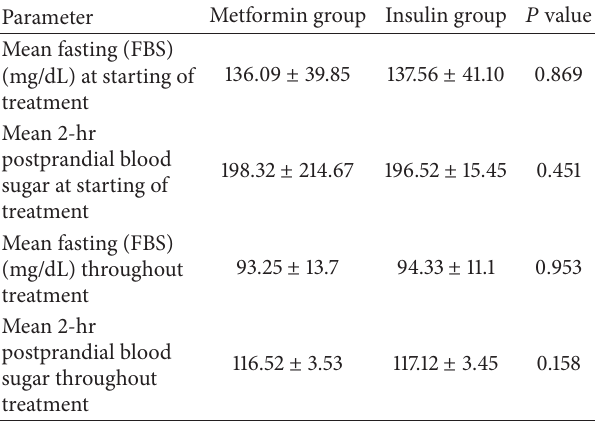
Table 2: Fasting blood sugar (FBS) and mean 2-hr postprandial blood sugar at start and throughout treatment